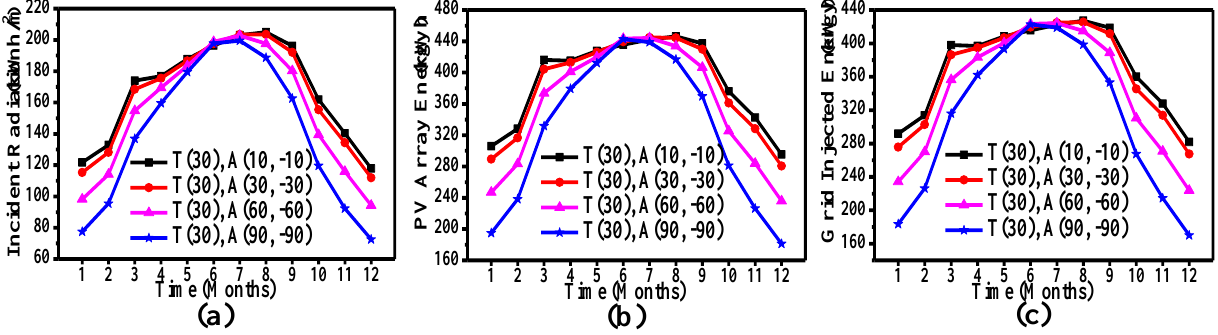
Figure 9: [Carport-T(30), A(x, -x)] Configuration: (a) incident radiation received by the module surface, (b) generated energy by the array, and (c) energy injected to the